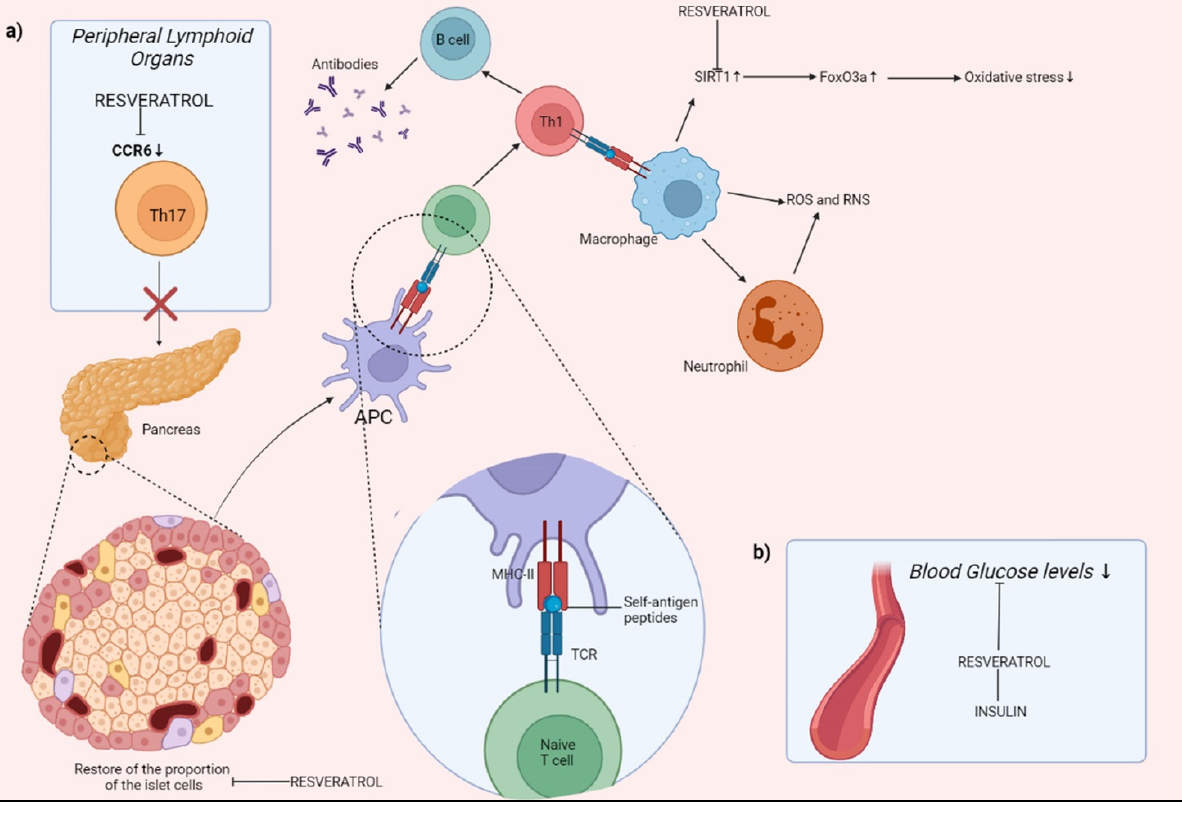
Figure 4. RSV action on DM. ( a ) action on CCR6, ( b ) action on insulin. Created with BioRender.com (Web online version 2021. Accessed on 28 December 2021).